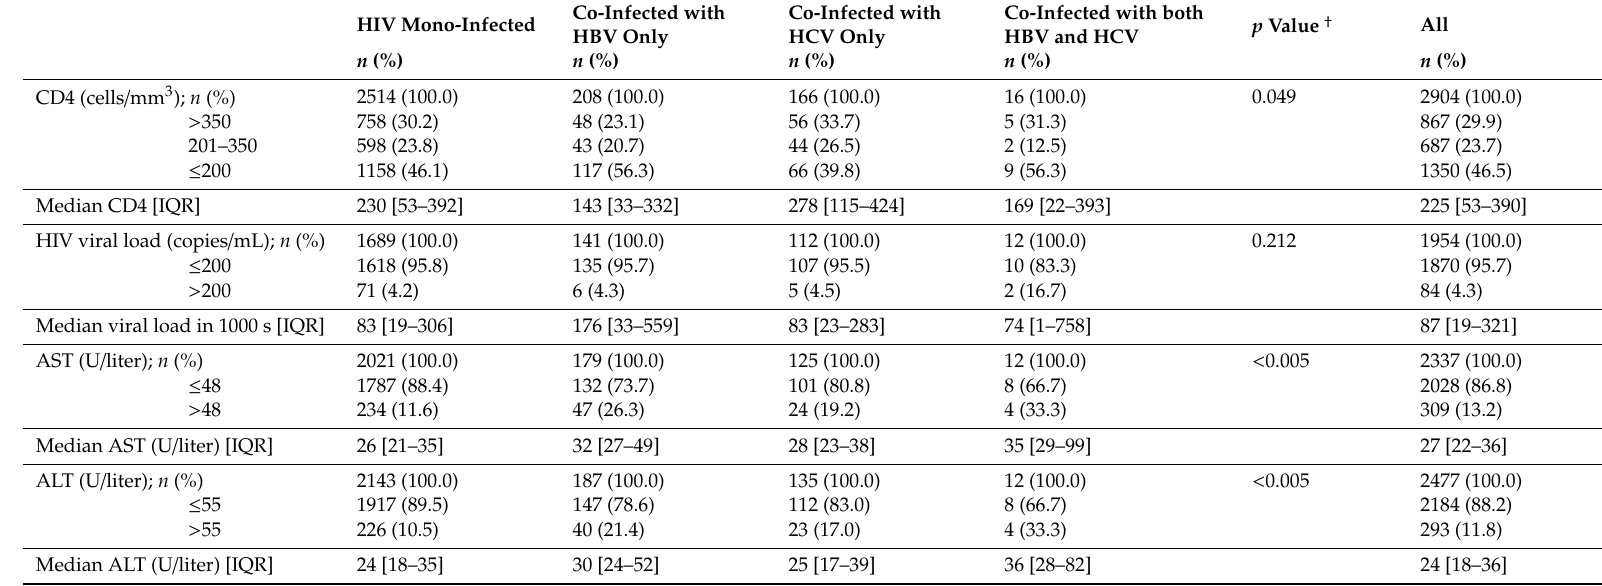
Table 2. Baseline clinical characteristics of HIV-infected patients with mono-infection and HBV and HCV co-infections who attended the national referral centre for HIV in Singapore, 2006–2017